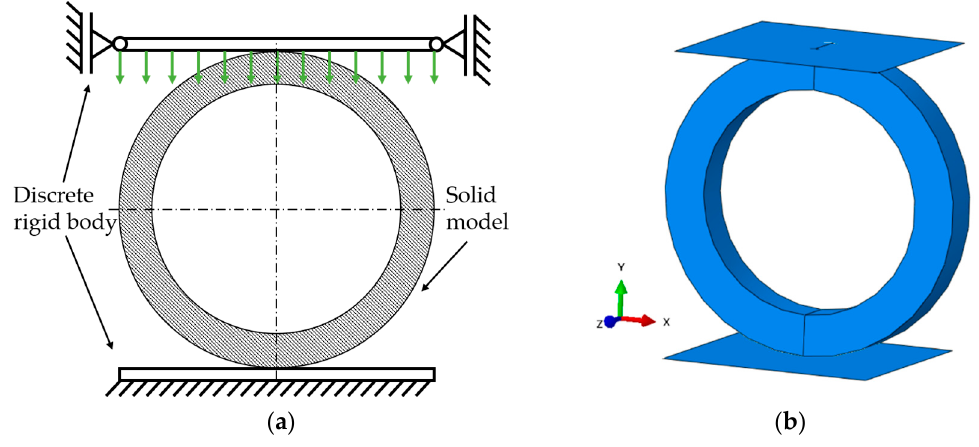
Figure 6. Boundary conditions ( a ) and geometric model ( b ) of the ring.